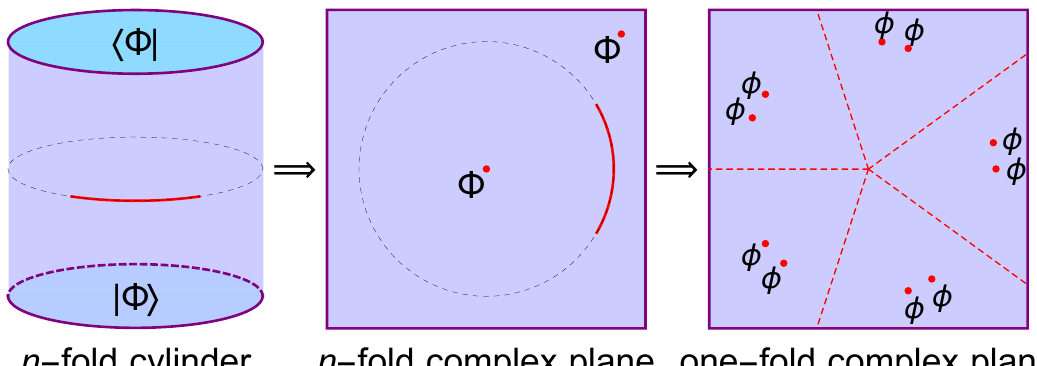
Figure 3 . This (cid:12)gure illustrates the replica method of multi-point function on complex plane [26{ 32]. Firstly, one has the one-fold CFT on an n -fold cylinder in excited state j (cid:8) i . Then, by state/operator correspondence one gets a two-point function on an n -fold complex plane C n . Lastly, by a conformal transformation one gets a 2 n -point function on a one-fold complex plane. In the last part of the (cid:12)gure we use n = 5 as an